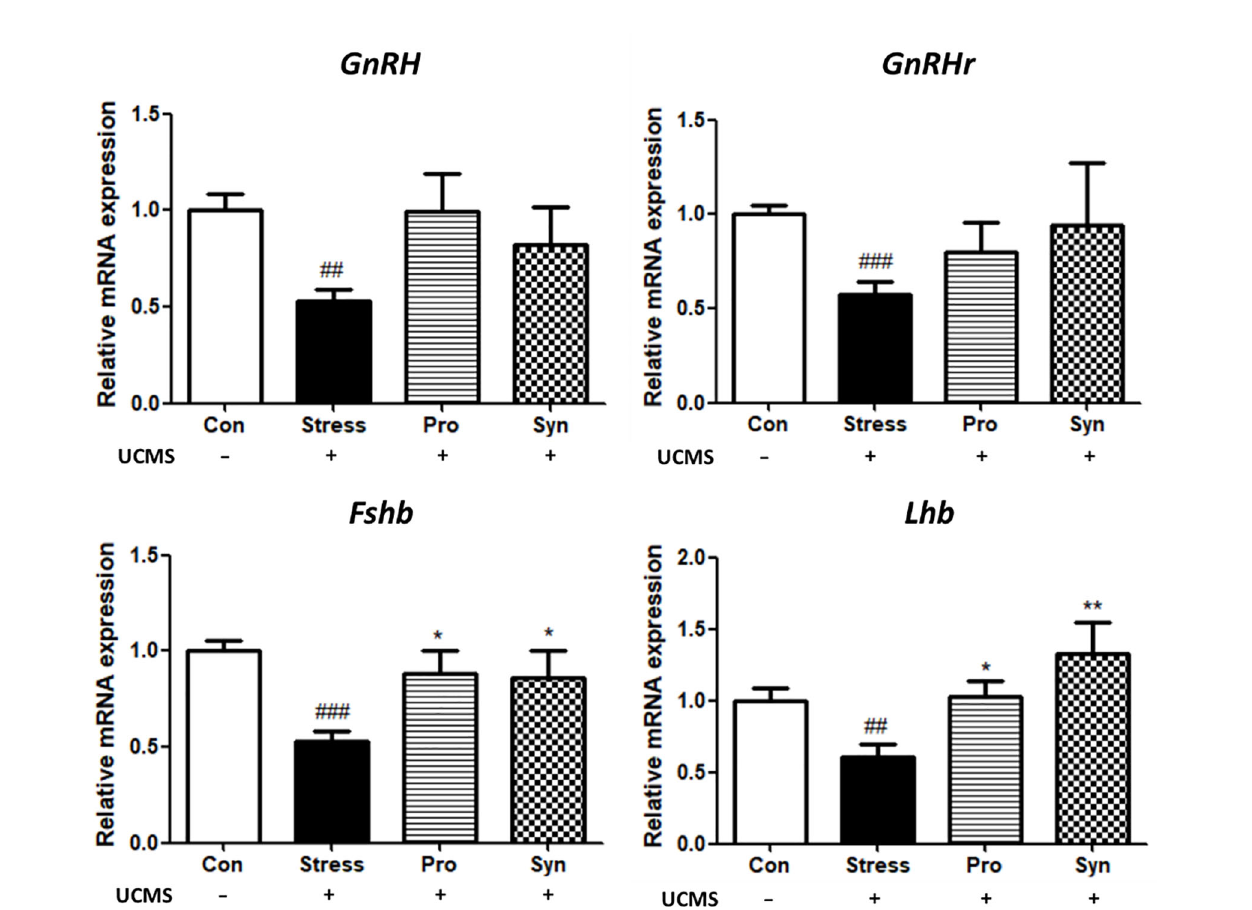
FIGURE 3 | Effectsofprobiotics andsynbioticstreatmentsonthetranscriptionofgenesrelatedtotheHPG axisinmousebrainsduringUCMS.Datarepresents therelative expressionof GnRH , GnRHr , Fshb ,and Lhb comparedto Gapdh . Dataare expressedasthemean± SEM(n=12)from threeindependentexperiments. # Signi fi cantdifference whencomparedto theCongroup( # p <0.05, ## p <0.005, ### p <0.001).*Signi fi cantdifferencewhencomparedtotheStressgroup(* p < 0.05,** p <0.005,*** p